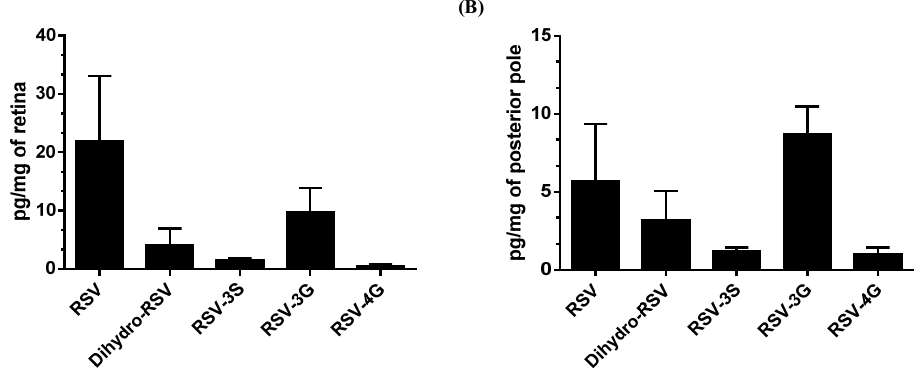
Figure 7. Resveratrol aglycone and resveratrol metabolites accumulate in retinal tissue of mice. ( A ) Analysis of RSV metabolites and RSV aglycone in retina lysates and ( B ) posterior pole in mice ( n = 5) treated with RSG (12 µM) for 21 days.